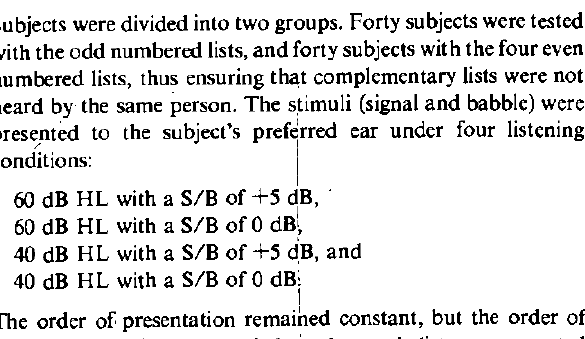
F-values obtained in four ANOVA's to test the difference between four scores (total HP, LP and Dif- ference) obtained under four listening